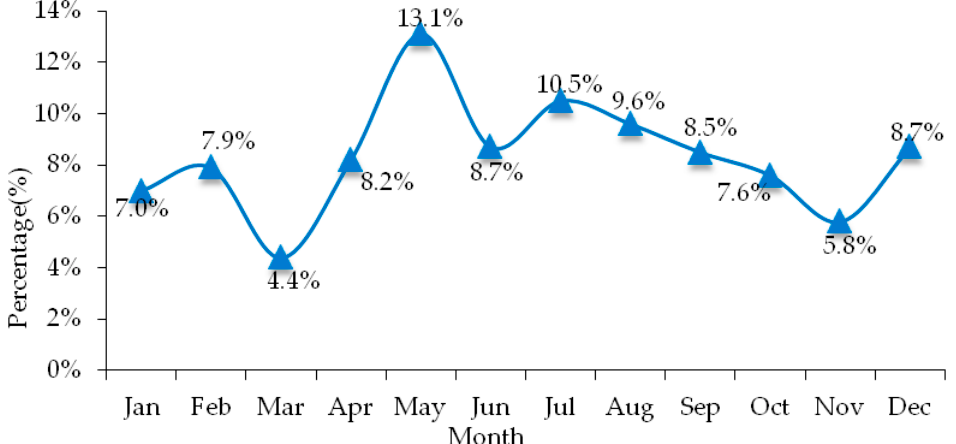
Figure 3. Month distribution characteristics of road hazardous materials accidents.